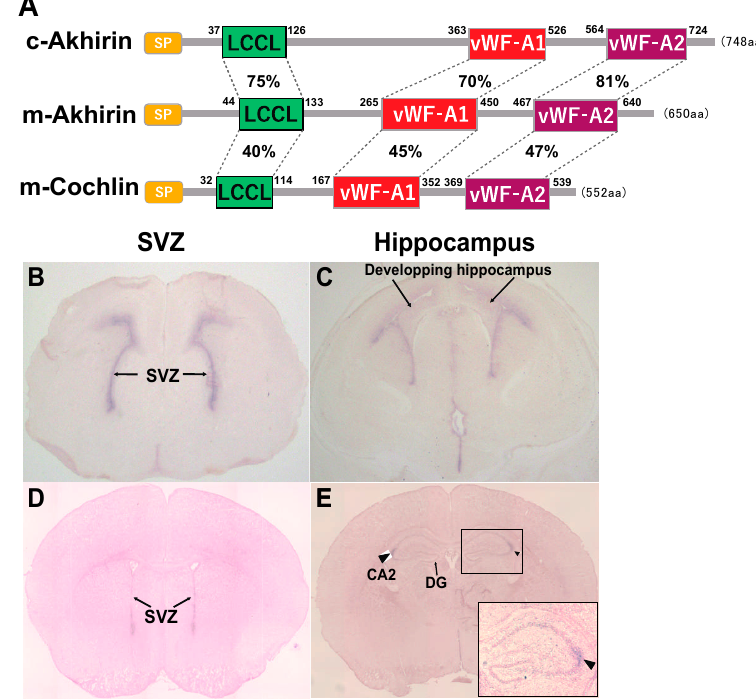
Figure 1. ( A ): A simple schematic diagram of chick and mouse AKH, mouse cochlin protein structure. The amino acid number is presented for each domain. ( B – E ): The expression of AKH mRNA in SVZ ( B , D ) and the hippocampus region ( C , E ) of the mouse brain at E17 ( B , C ) and P20 ( D , E ). Arrows indicate SVZ niche areas along the LV regions ( B , D ) and the developing hippocampus ( C ). Arrowheads indicate the hippocampal CA2 region ( E ).